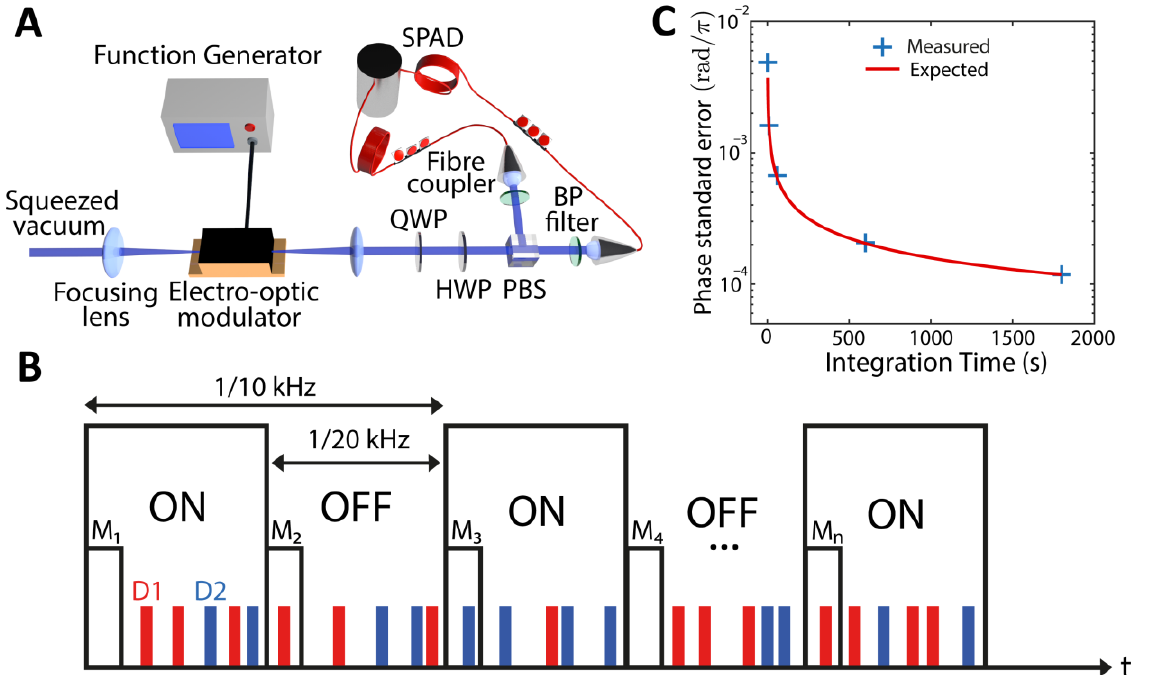
Figure 2. Calibration setup with EOM and experimental lock-in-like balanced detection using two single-photon detectors. ( A ) Experimental scheme for calibration of detection using electro-optic modulation. ( B ) Using ps-time tagging resolution of the photon counting software, a difference measurement was performed between counts of detectors D1 (red) and D2 (blue) using markers M inserted every 1/20 kHz to synchronize timing with the antenna modulation. ( C ) Measured standard error of the detection method using EOM with single photon counts.